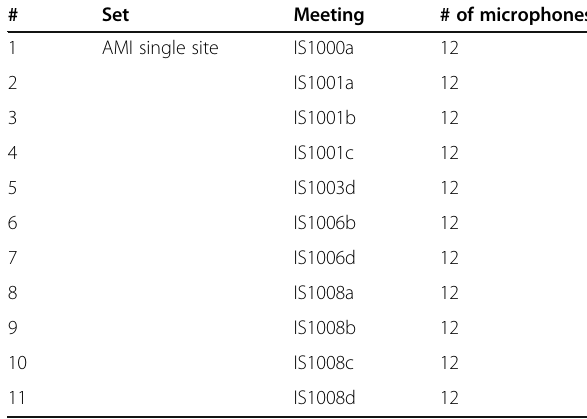
Table 12 List of meetings from AMI meeting